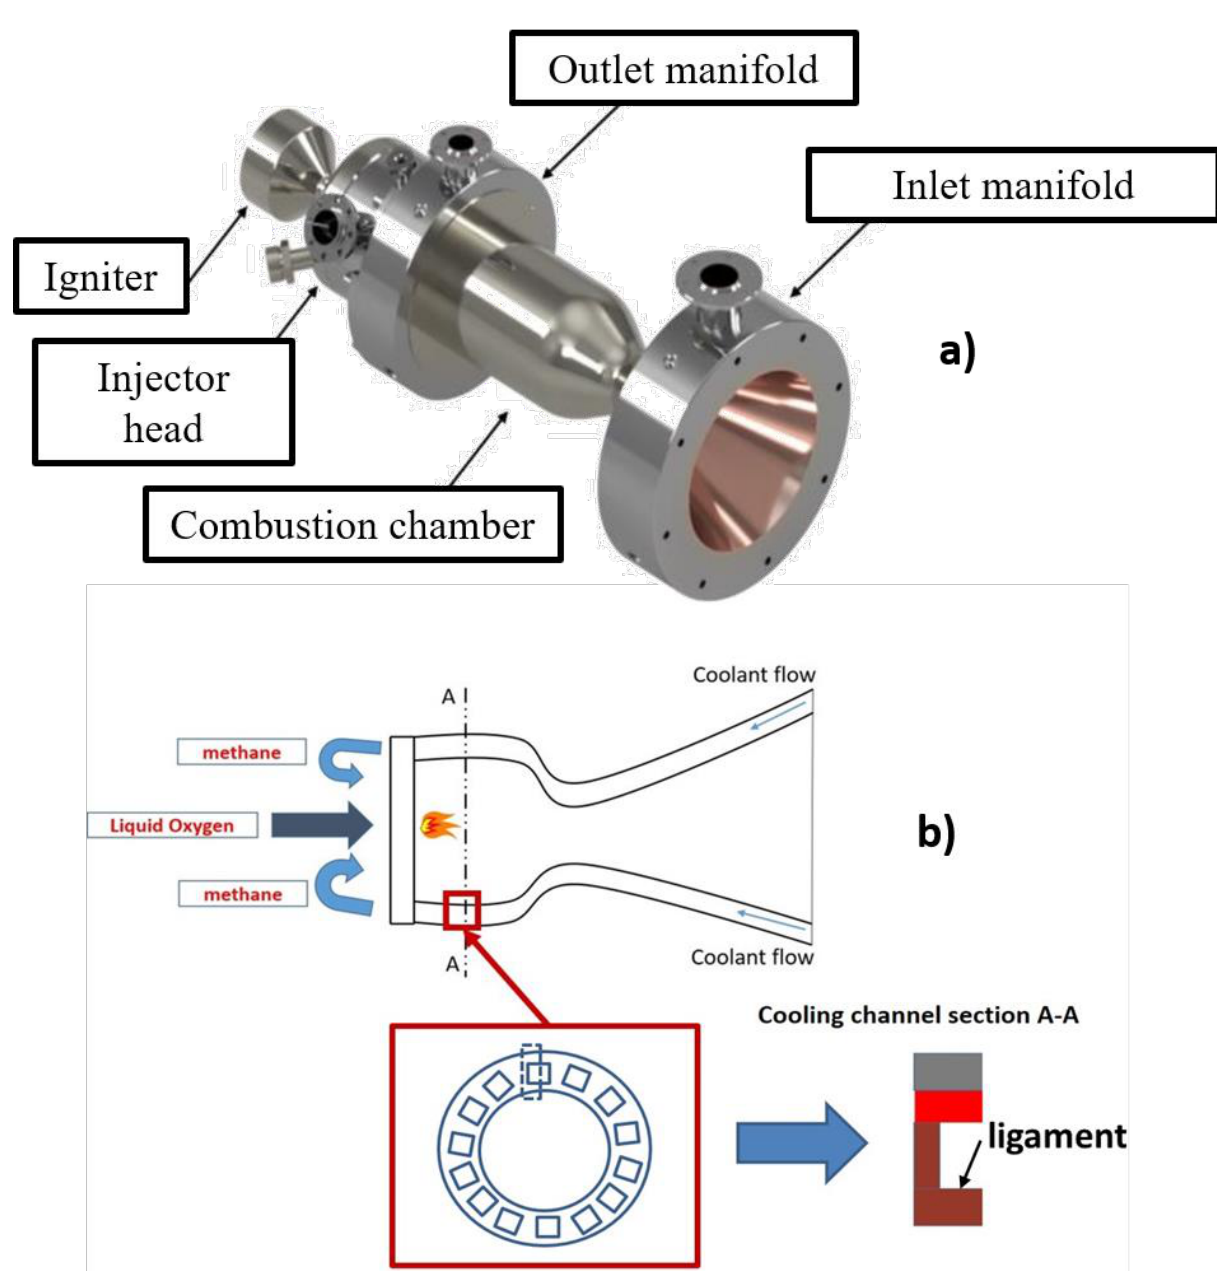
Figure 1. Rocket engine thrust chamber ( a ) and related functional scheme ( b ).